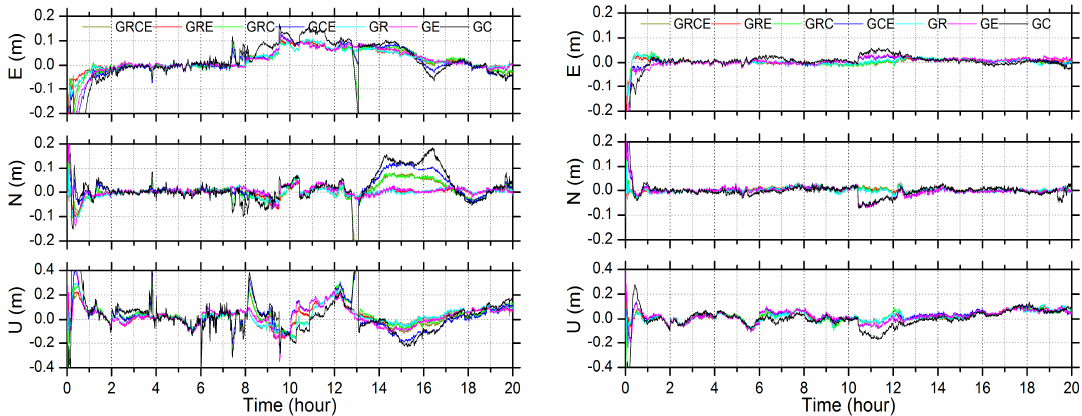
Figure 7. The positioning error of the multi-GNSS combined PPP without ( left ) and with ( right ) quality control at station BRST.